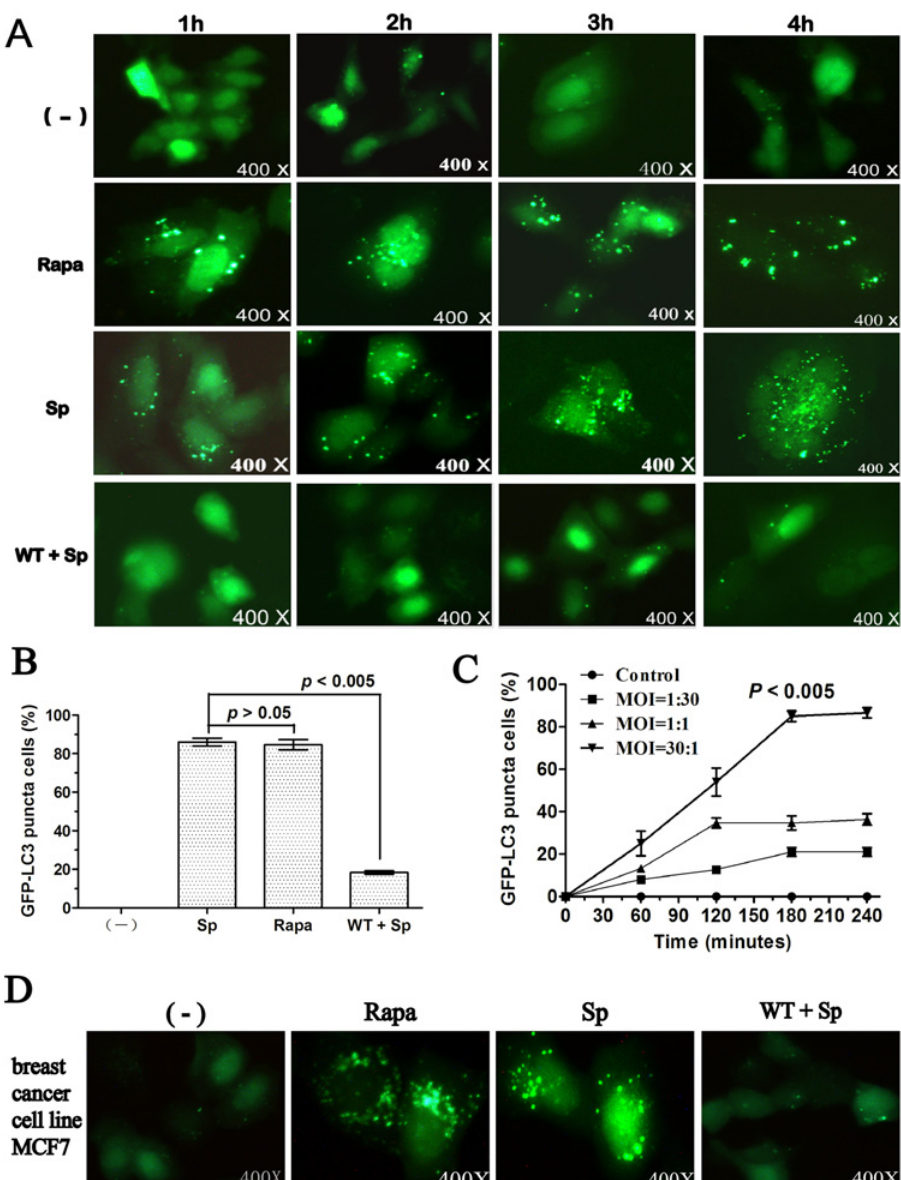
Fig 1. Sp infection induced LC3 punctation in A549 cells. A549 cells were infected with Sp (st35A) for 1 h (MOI=30:1). Before infection, the cells were treated with rapamycin (1 mM, 10 h) and wortmannin (2 μ M, 2 h). (A) A549 cells were transfected with GFP-LC3 plasmids for 24 h. Then, the cells were infected with Sp for 1 h (MOI=30:1). (B) The puncta in each cell were counted and cells with more than 10 punctae were considered GFP-LC3 puncta cells. Values are from 100 cells/sample (one-way ANOVA; Tukey ’ s posthoc test). (C) A549 cells were infected at different times and with different MOIs. (D) Breast cancer cell line MCF7 cells were infected with Sp (st35A) for 4 h (MOI=30:1). The percentage of GFP-LC3 puncta cells was determined (one- way ANOVA; Tukey ’ s posthoc test). Data are representative of three experiments with similar results. Sp: S . pneumoniae ; Rapa: rapamycin; WT: wortmannin.